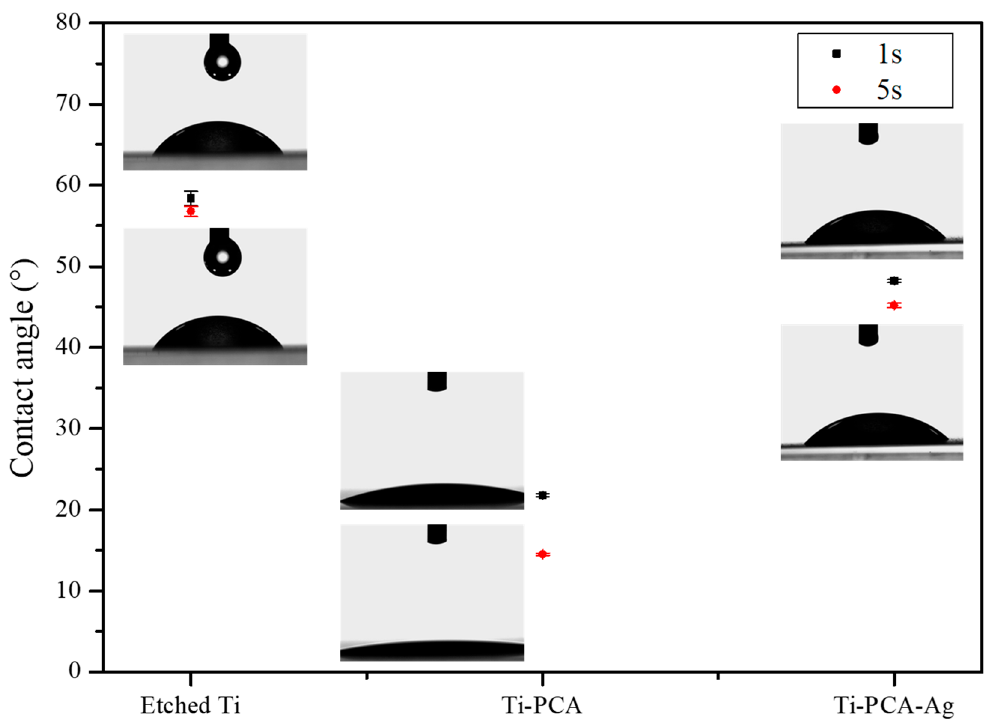
Figure 4. Contact angle values of the Etched Ti (control), Ti–PCA, and Ti–PCA–Ag measured in 1 and 5 s ( n = 3).